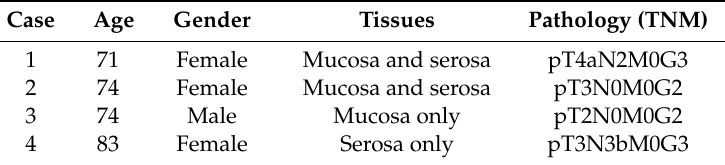
Table 1. Information about patient and sample characteristics.